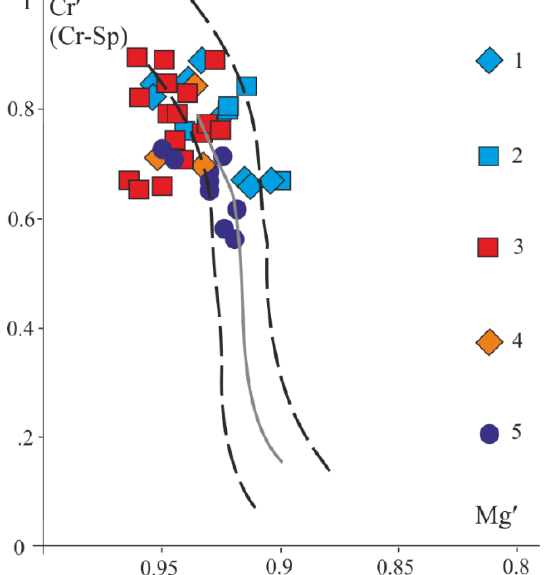
Figure 12. OSMA (olivine-spinel mantle array) is a spinel peridotite restite trend [52]. The chrome spinels are from: 1–4—the Ospa-Kitoy ophiolite: 1—dunites; 2—harzburgites; the chromitites are from: 3—the north-branch Ospa-Kitoy, 4—south-branch Ospa-Kitoy; 5—Ulan-Sar’dag ophiolite.